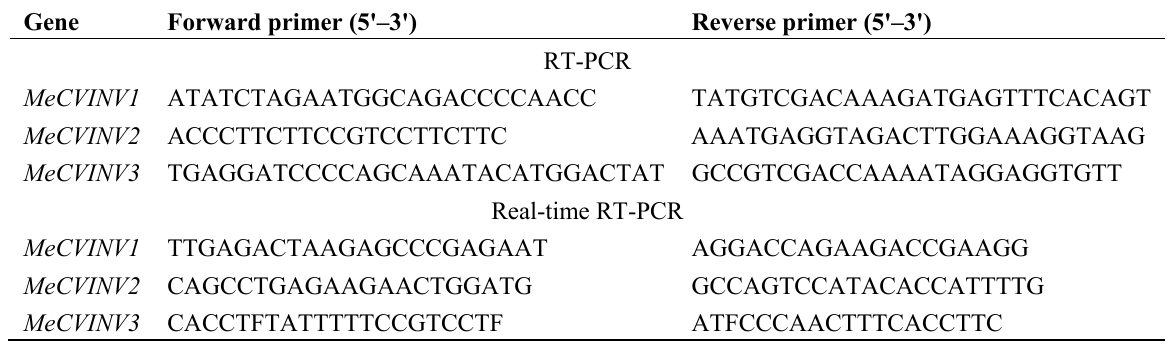
Table 2. Gene specific primers used for RT-PCR and real-time